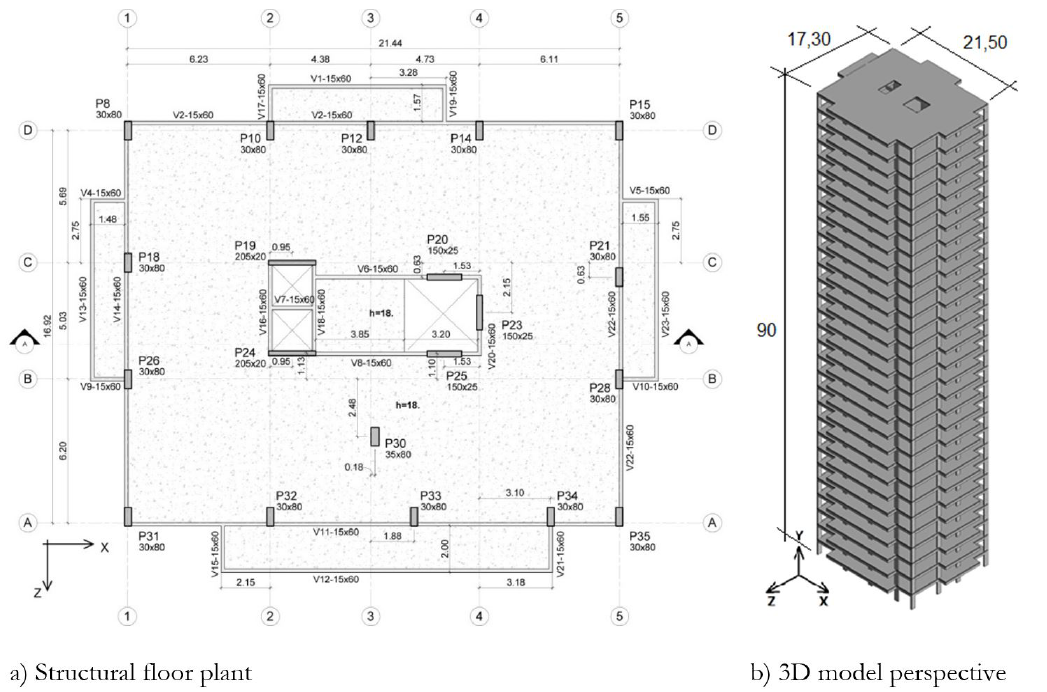
Figure 5. Investigated structural model.